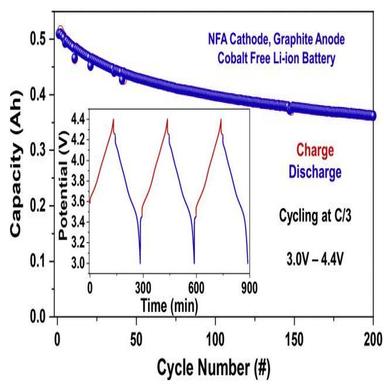
Galvanostatic charge/discharge cycling (C/3 between 3.0V and 4.4V) performance evaluation of a cobalt free Li-ion battery enabled by the NFA cathode material (inset-charge/discharge profiles exhibited by the cobalt-free lithium ion battery between 3.0V and 4.4V).